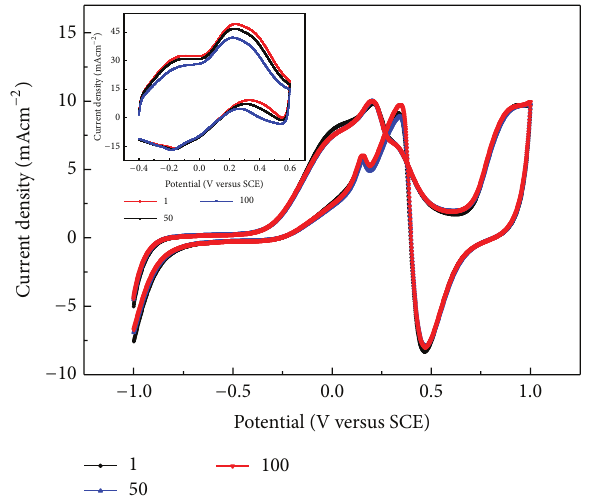
Figure 5: CV curves of NPC-G2 number before and after 100 potential cycles in 0.1mol/L KOH alkaline aqueous solutions with 50 mmol/L glucose, scan rate 0.05 V/min. The inset is the CV curves of NPG during 100 potential cycles in the same conditions, versus